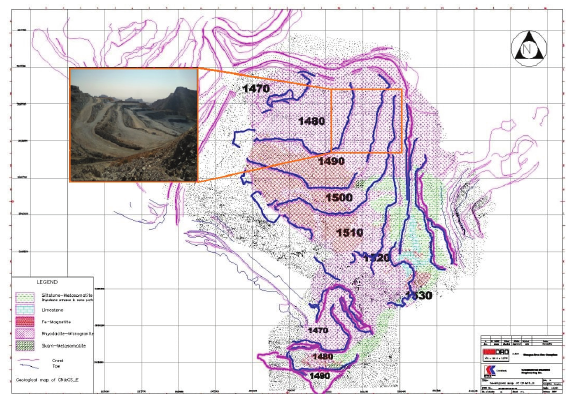
Figure 5: The location of the studied bench in Sangan iron mine